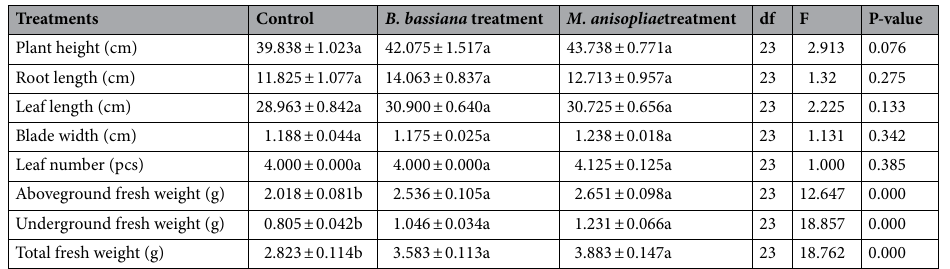
Table 1. Effects of B. bassiana and M. anisopliae on biomass of maize seedlings after 7 days of treatment. The same lowercase letters in the same column indicates means ± SE are not significantly different using Tukey HSD test at p = 0.05 level of significance; the same as below.